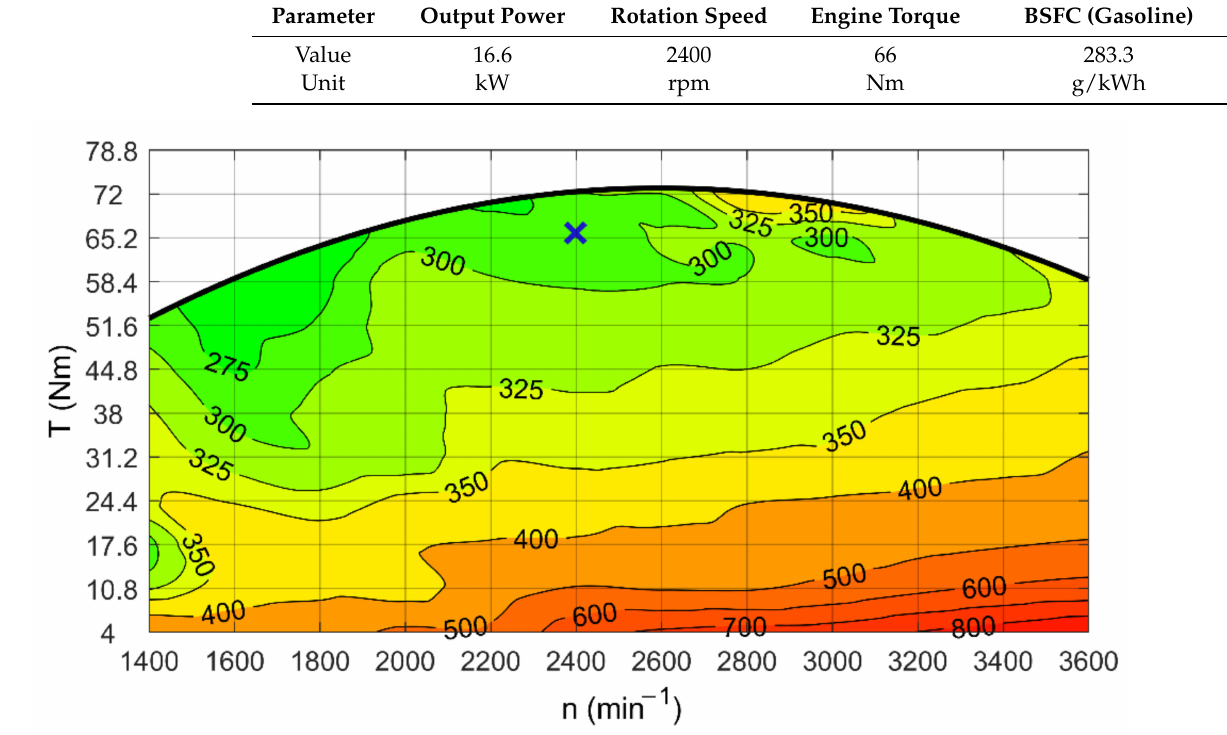
Figure 6. BSFC map and operating point of range extender running on gasoline